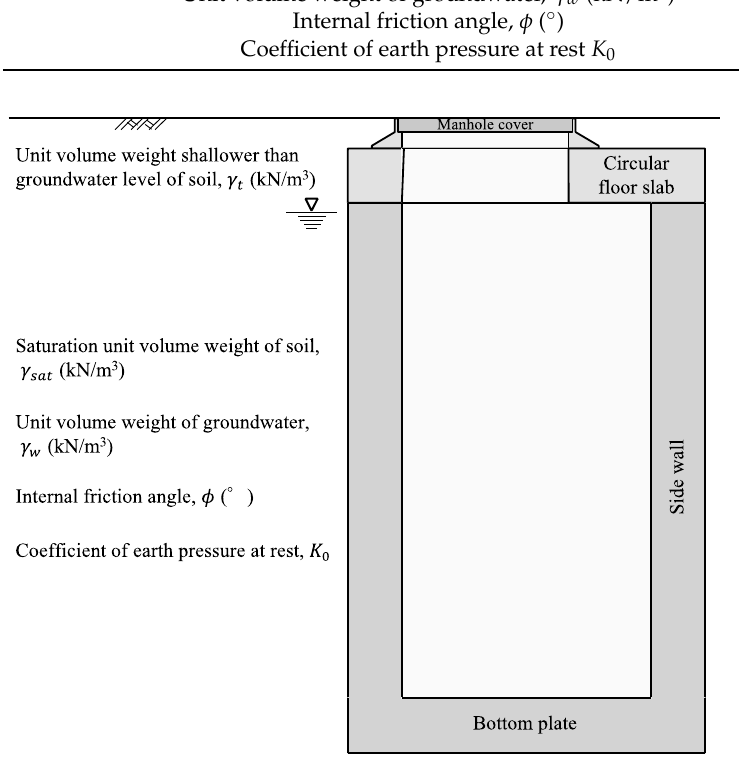
Figure 6. Schematic diagram of analysis conditions.